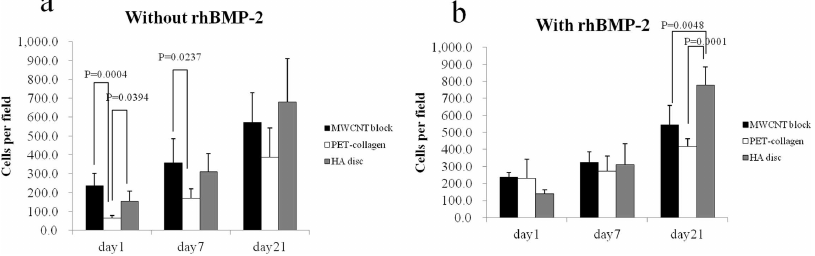
Fig 9. Proliferation of MC3T3-E1 cells on MWCNT blocks and PET-reinforced collagen sheets. Cell counts (mean ± S.D. * P < 0.05)on PET-reinforced collagensheets and MWCNT blocks in the (a) presenceand (b) absenceof rhBMP-2. Values are mean ± S.D.; n =